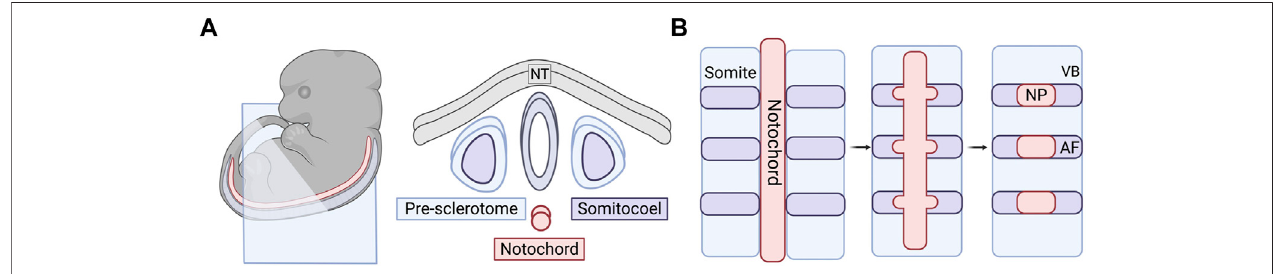
FIGURE2| Embryonicandearlyformationoftheintervertebraldisc(IVD). (A) Embryonictissuesandcellsourcesthatplayaroleinformingthespinalcolumn.Right panelisacross-sectionalviewofthebluecutplaneindicatedintheembryointheleftpanel. (B) Sclerotomeandsomitecondensationinformationofvertebralbodiesand theannulus fi brosus.NotochordcondensesintodistinctbulgesalongthelongaxiswheretheNPwillform.TheAFtissuesurroundstheformingNPovertimeandtheVBs sectionoffinbetweentheindividualIVDs.NT,neuraltube;IVD,intervertebraldisc;VB,vertebralbody;AF,annulus fi brosus;NC,notochord;NP,nucleuspulposus.